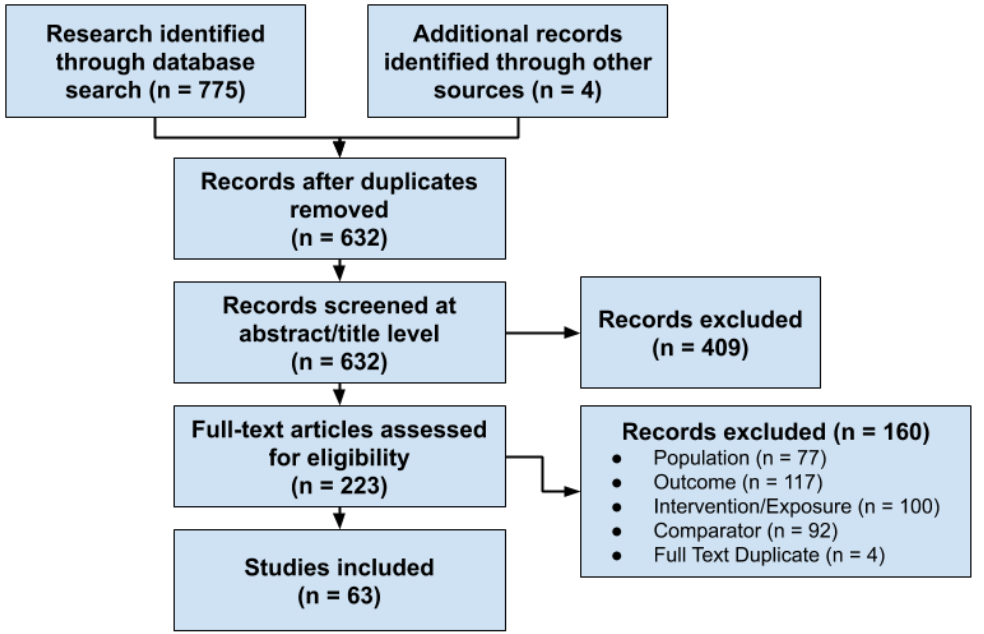
Figure 2. Flow diagram of the screening process. Please note that one record can be excluded for multiple